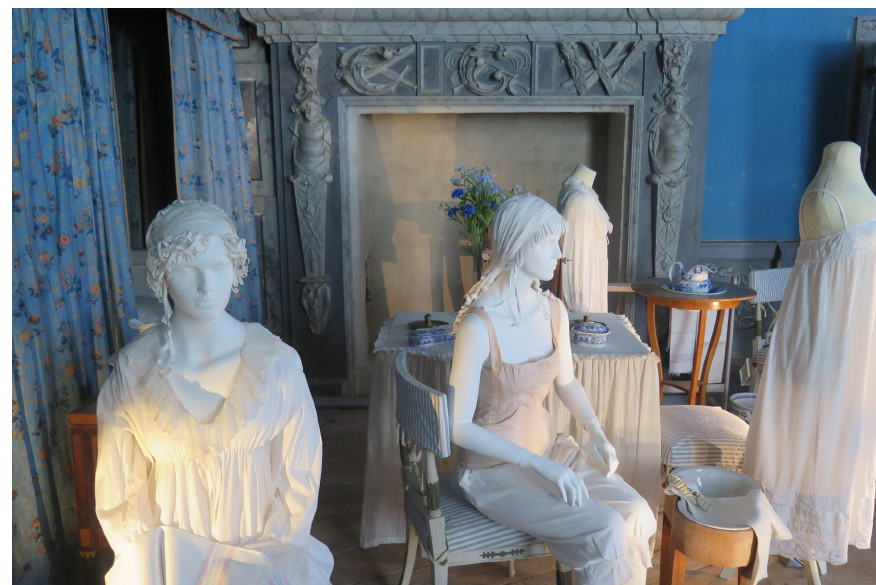
Figure 3: Scene from the temporary exhibition Jane Austen’s World at Skokloster Castle, 2017. One of the aims of this exhibition was to activate Austen’s stories in the castle setting to shed light on the role of women in the aristocratic society in the eighteenth and nineteenth centuries. (Photo: Lizette